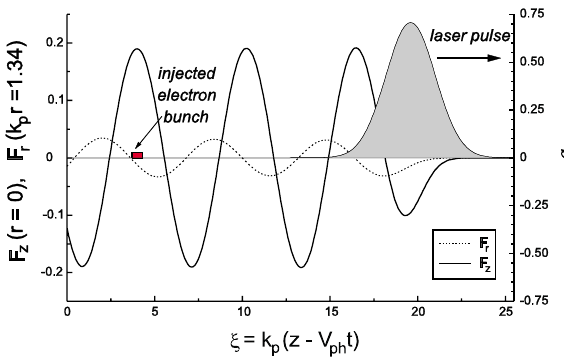
FIG. 1. (Color) Accelerating F z and focusing F r wakefield forces in a matched parabolic plasma channel; CO 2 laser t L (cid:1) 1 ps, P L (cid:1) 50 TW, a 2 (cid:1) 0.5 ; plasma parameters k p r L (cid:1) 3.8 , k p R ch (cid:1) 14.3 , l p (cid:1) 800 m m.